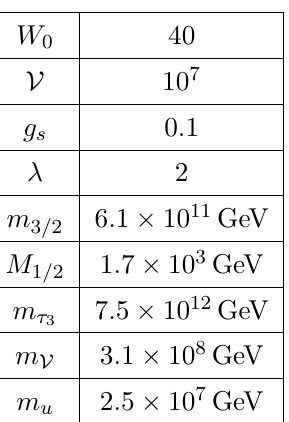
is obtained 1 / 2